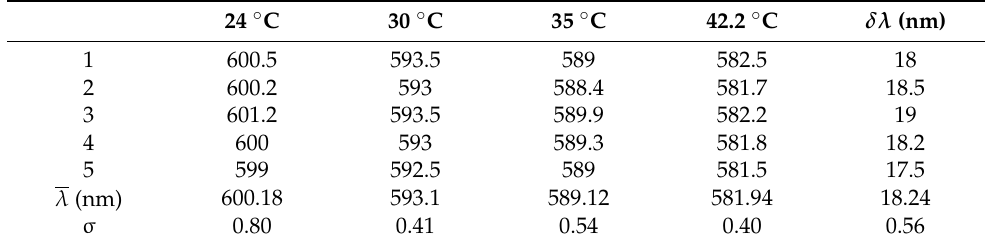
Table 1. Emission wavelength of different devices with the function of increasing